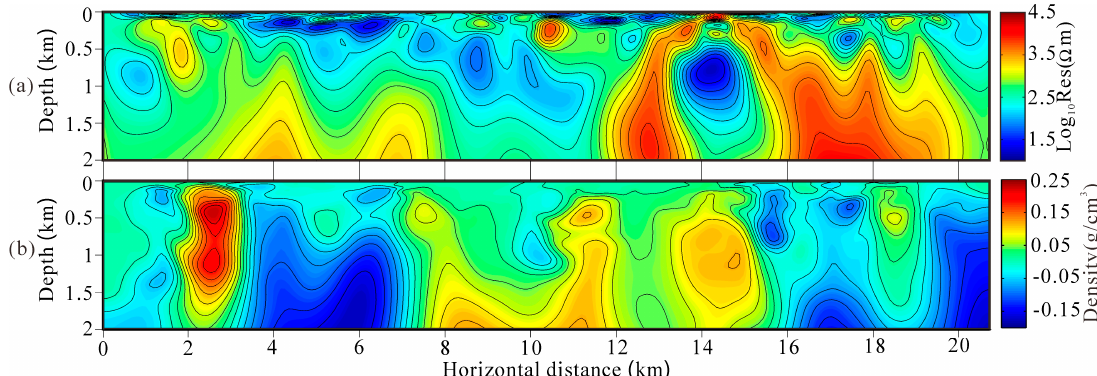
Figure 15. The results of joint inversion using elastic-net regularization: resistivity model ( a ), residual density model ( b ).